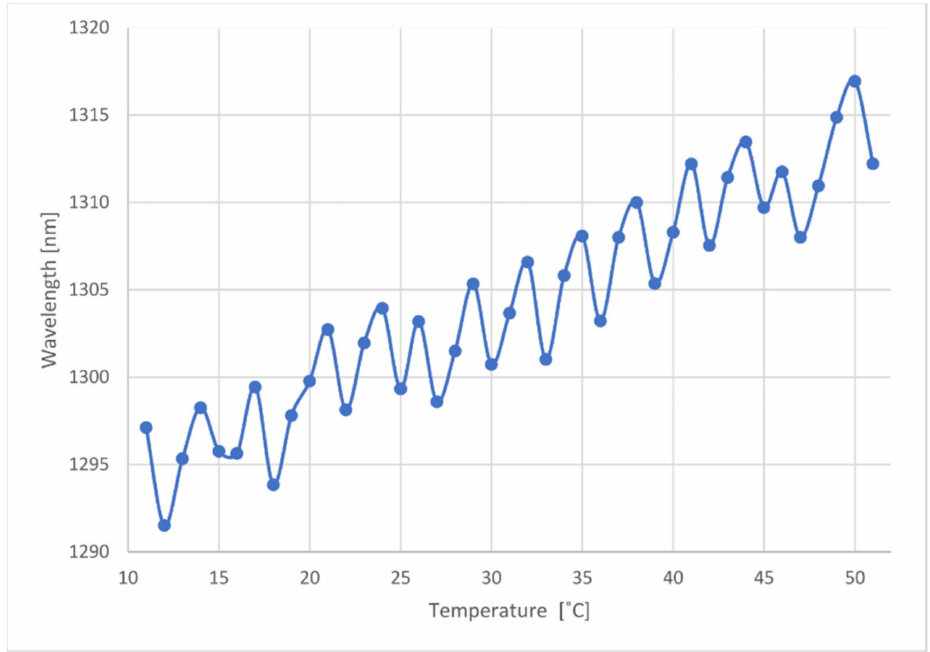
Figure 5. The wavelength of the laser’s dominant mode as a function of temperature, for a constant current of 25